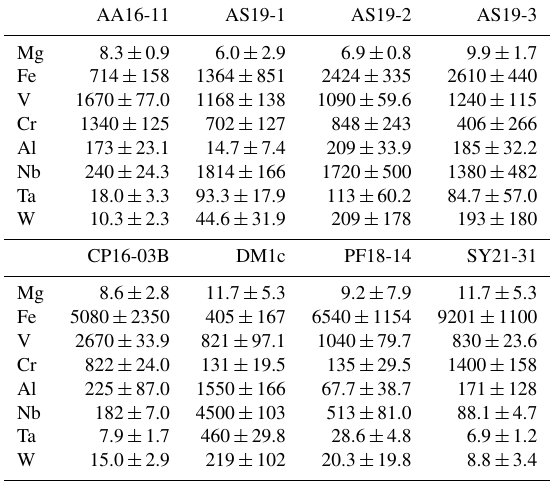
Table 3. Rutile trace-element content, measured by LA–ICP–MS, values given in µgg − 1 with 2 σ